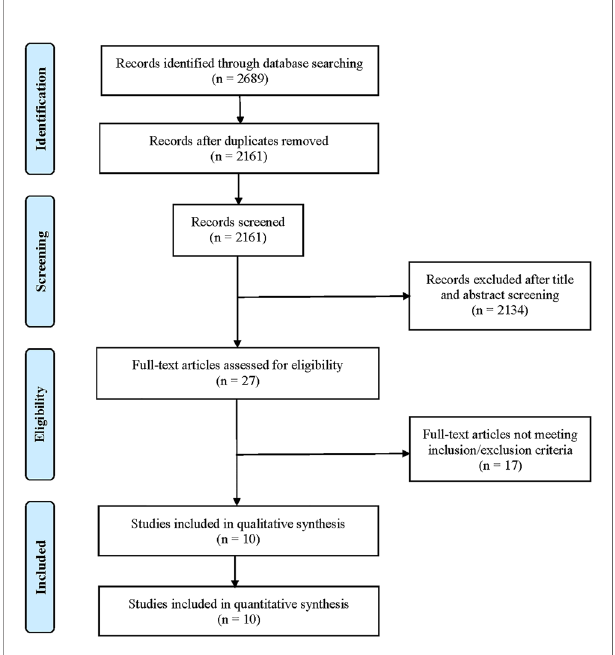
FIGURE 1 | Flow diagram of study inclusion and